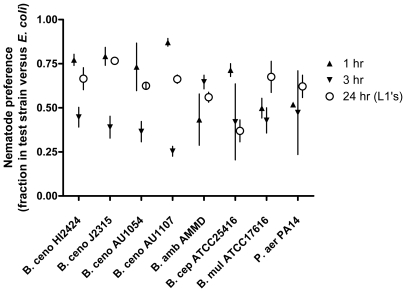
Nematode preference to bacterial culture supernatants.
C. elegans prefers the spent cell-free culture supernatant of some Bcc strains to that of its prior E. coli diet. Cell-free supernatant from each Bcc strain was spotted opposite that from an E. coli OP50 culture. The fraction of nematodes traveling towards the Bcc supernatant within 1 h (up triangles) and then towards the E. coli supernatant by 3 h (down triangles) is shown. Within the first day, eggs from adult nematodes hatched and neonate migration at 24 h was observed (open circles). The error bars are SEM from three replicate assays.